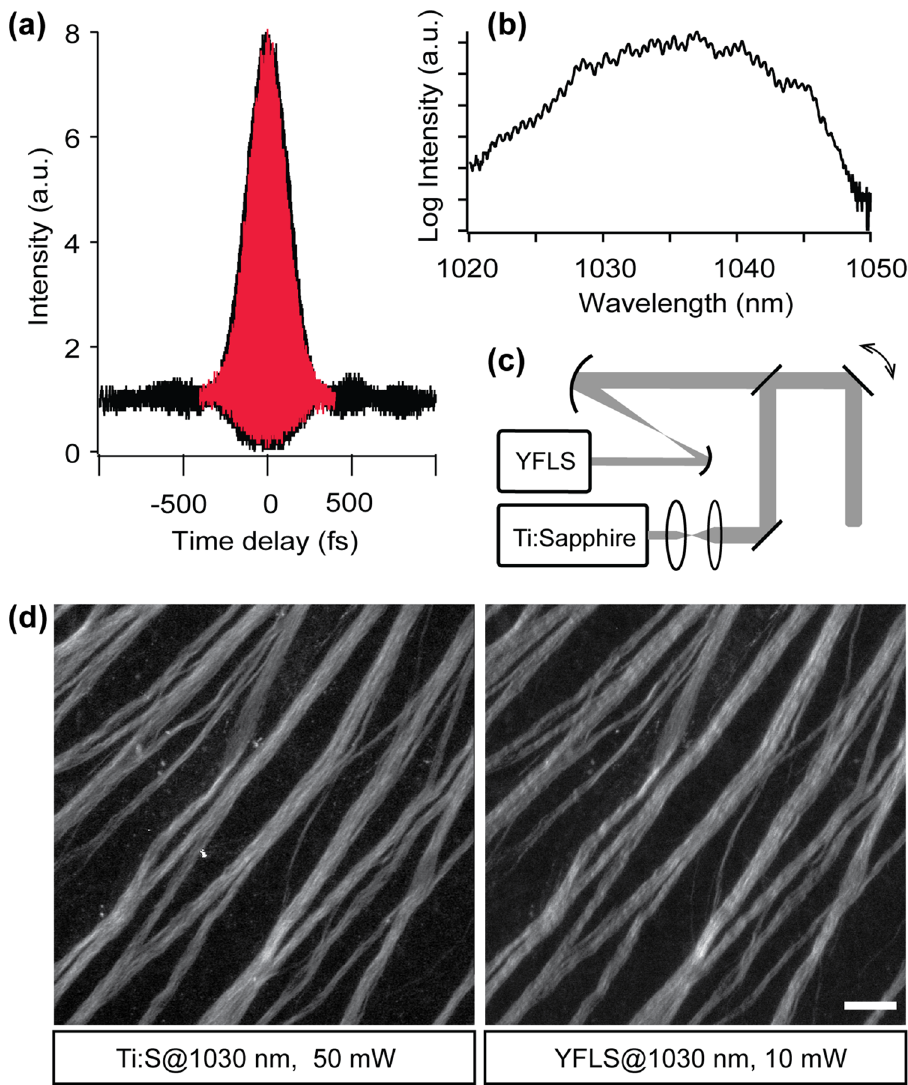
Figure 1. Setup for high-pulse-energy MPM. ( a ) Autocorrelation and ( b ) spectrum of a pulse from the YFLS. Overlaid in red, a pulse from the Ti:Sapphire laser. ( c ) The excitation beam path. ( d ) SHG images of the retinal nerve fiber bundles, confirming the 2PE equivalent average power. Scale bar, 30